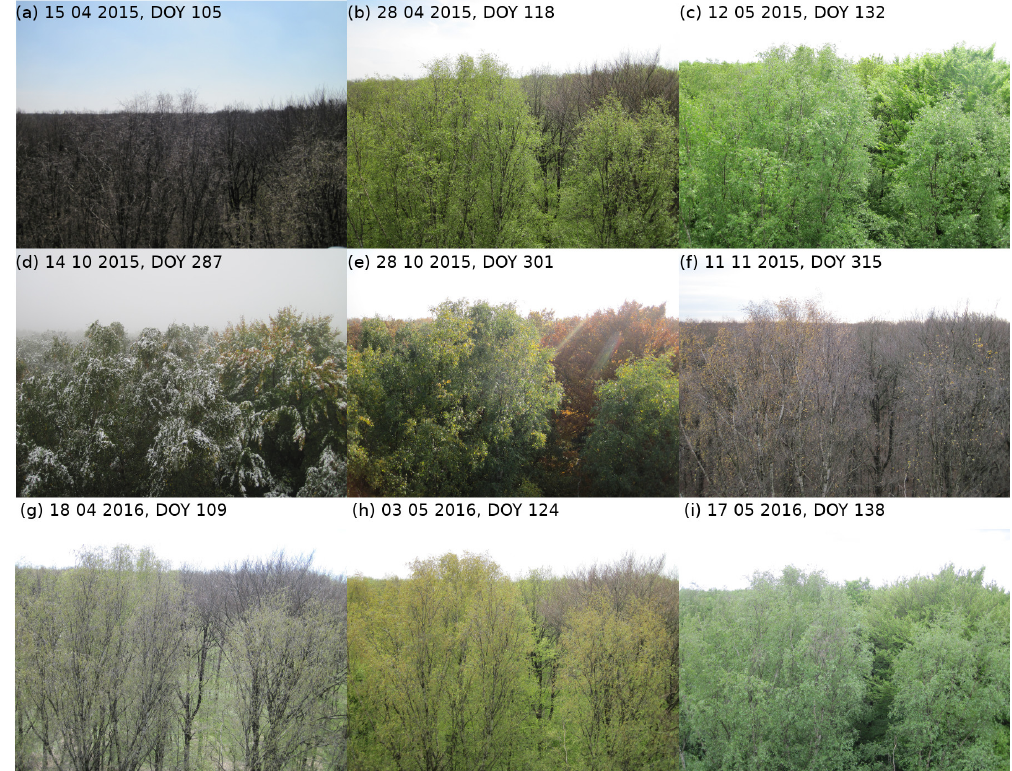
Figure 8. Pictures of phenological state of vegetation around the eddy flux tower ‘Hohes Holz’. ( a – i )